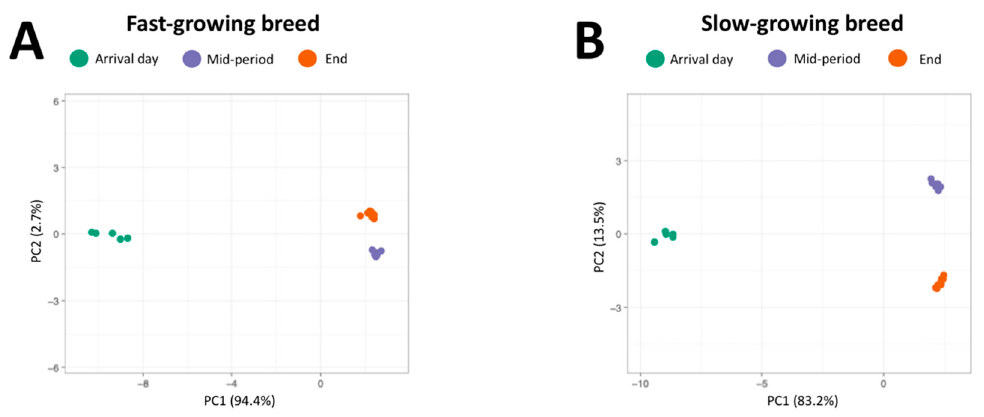
Figure3. EvaluationofthebetadiversitybasedonBray–Curtisdissimilaritybetweensamplingmoments Figure 3. Evaluation of the beta diversity based on Bray–Curtis dissimilarity between sampling (arrival day, mid-period and end of the rearing period) for each management system. ( A ): Beta diversity moments (arrival day, mid ‐ period and end of the rearing period) for each management system. ( A ): represented by a Principal Coordinate Analysis (PCoA) graphic for fast-growing management Beta diversity represented by a Principal Coordinate Analysis (PCoA) graphic for fast ‐ growing management system. ( B ): Beta diversity represented by PCoA graphic for slow ‐ growing management system.